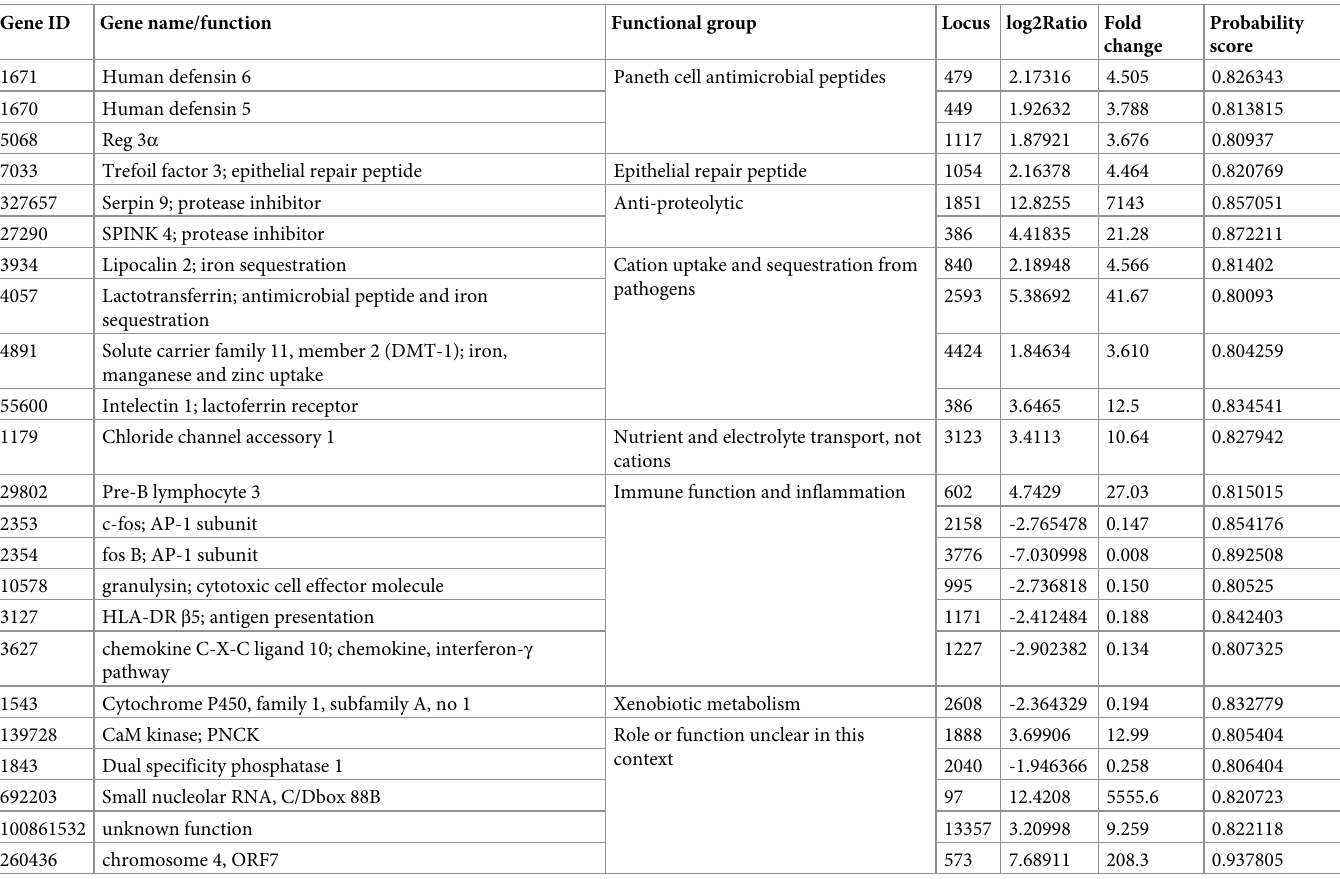
Table 3. Differentially expressed genes in 4 biopsies from duodenum with multiple plumes seen by confocal laser endomicroscopy compared to 4 with minimal